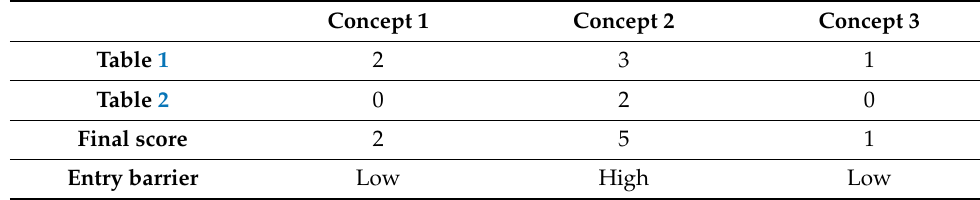
Table 14. Entry barrier. Final